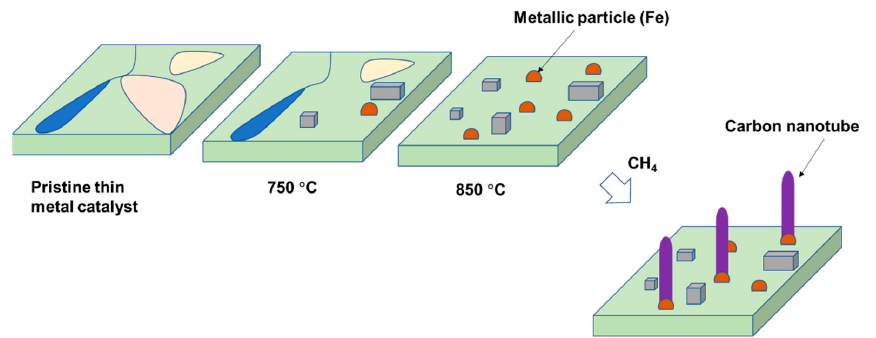
Figure 14. Schematic representation of the mechanism of CNT growth over thin-foil steel